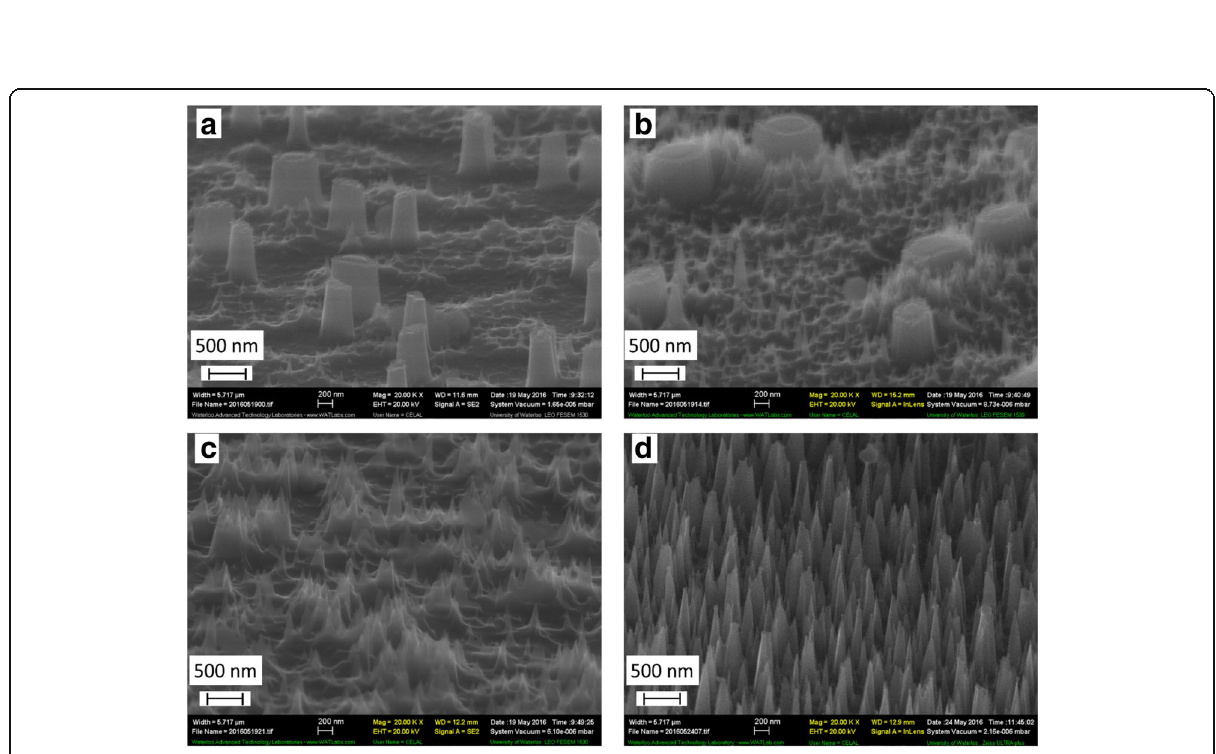
Fig. 4 SEM images of silicon nanopillars formed upon RIE using our process with aluminum nitrate nonahydrate: polymer. Ratio of aluminum metal salt: PMMA is a 1:10, b 2:10, c 3:10, and d